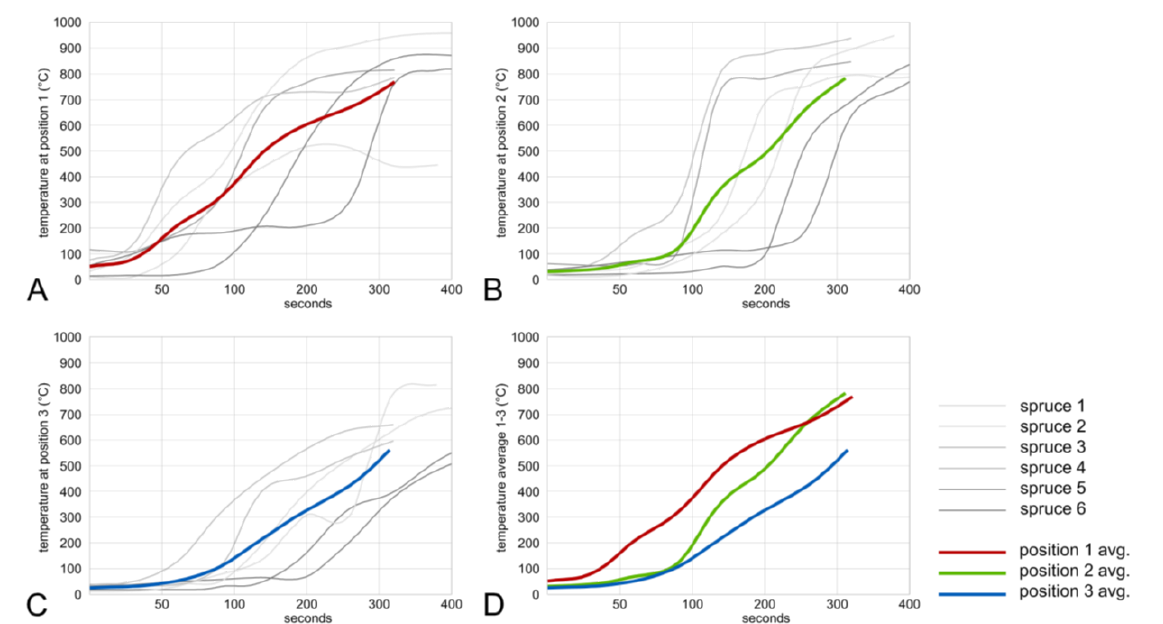
Figure 4. Temperature–time diagram for spruce samples at positions 1, 2, and 3 ( A – C ) and average temperatures ( D ).